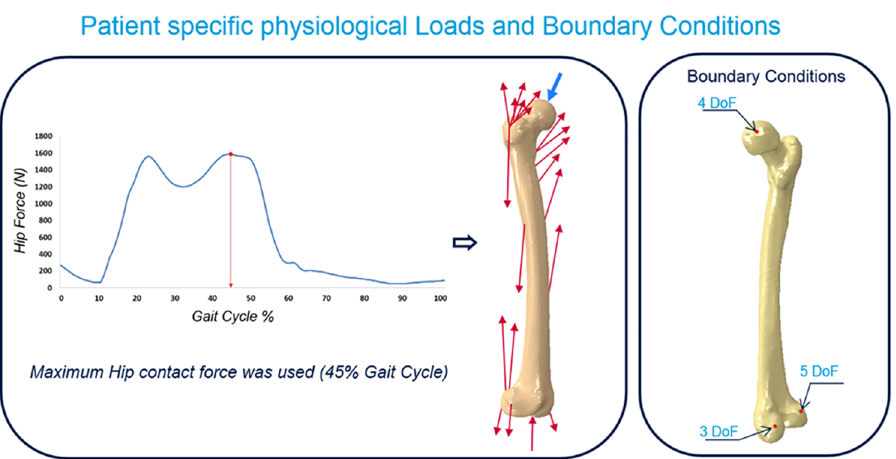
Fig 4. Physiological joint and muscle forces applied to the model and boundary conditions applied to the